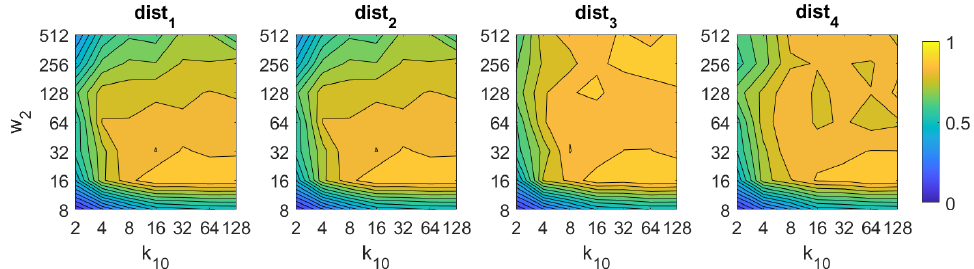
Figure 9. WS image retrieval problem. Success rate of the method. k 9 is the number of horizontal cells and w 1 the number of windows per cell (Table 1).